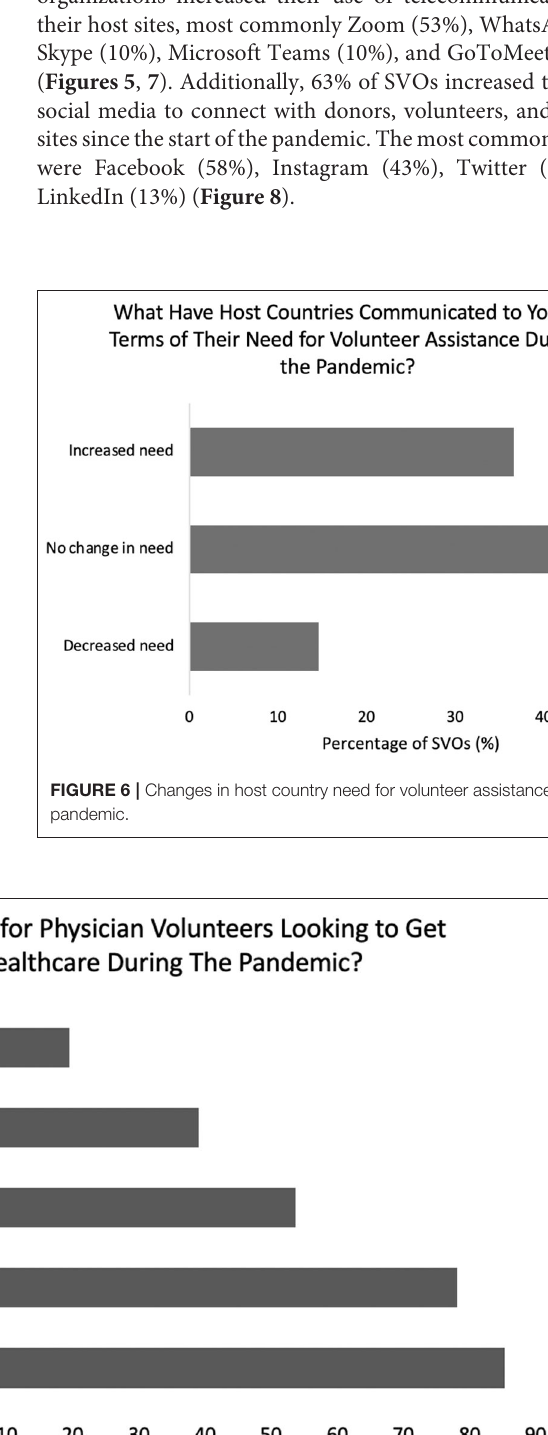
Frontiers in Surgery |